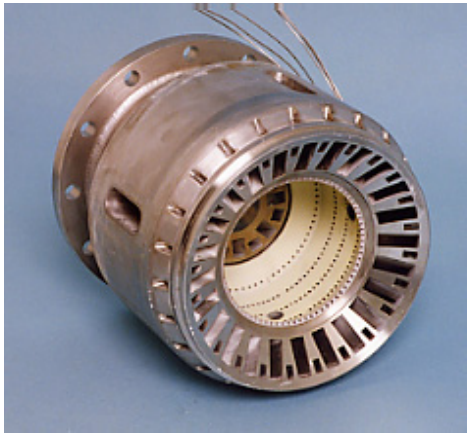
Figure 49. Tested